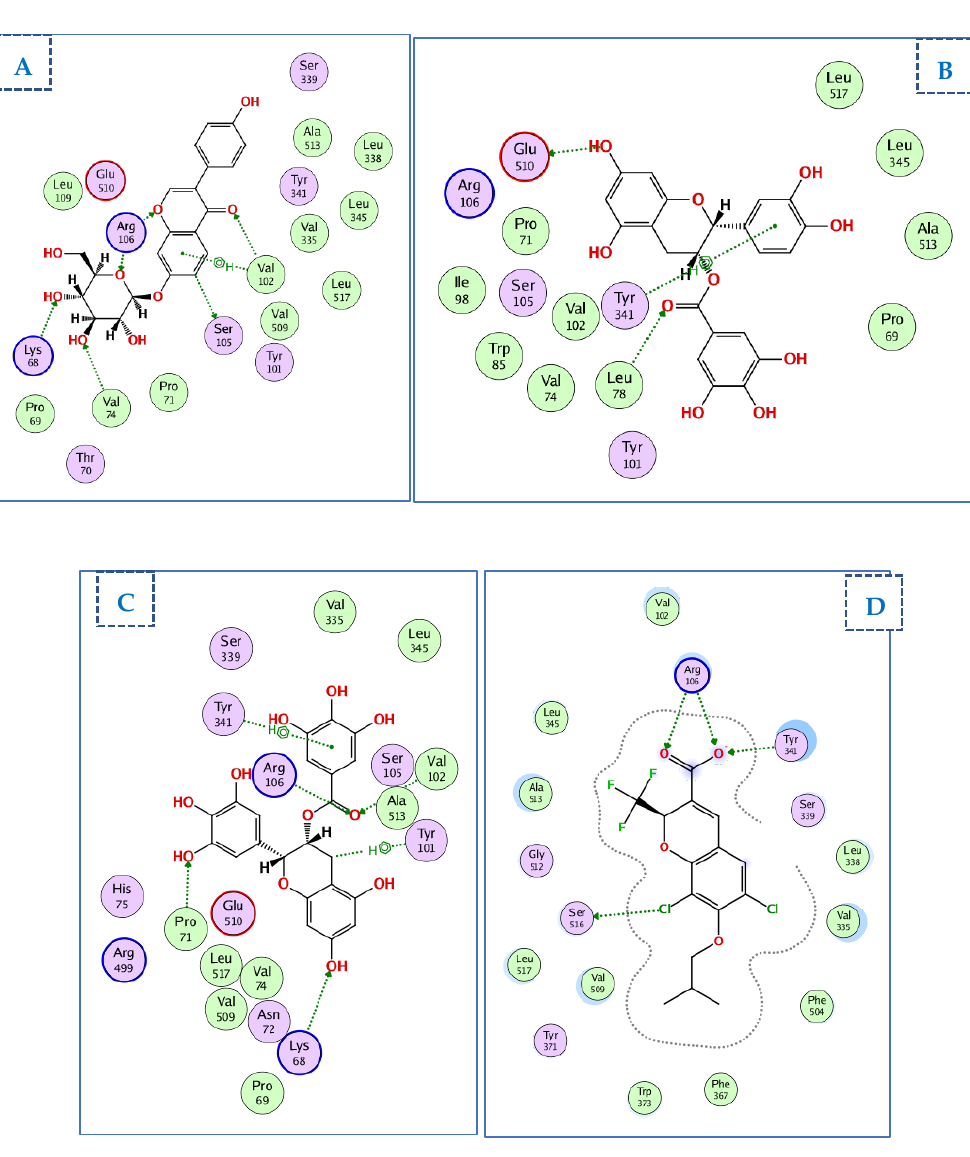
Figure 8. Two-dimensional diagram of ( A ) daidzin7-O-glucoside, ( B ) (-)-epicatechin, ( C ) epigallo- catechin, and ( D ) D72 moieties in the binding site of COX-2 (PDBID: 3ntg). (-)-epicatechin gallate displayed the highest docking score energy (−21.5 kcal/mol),